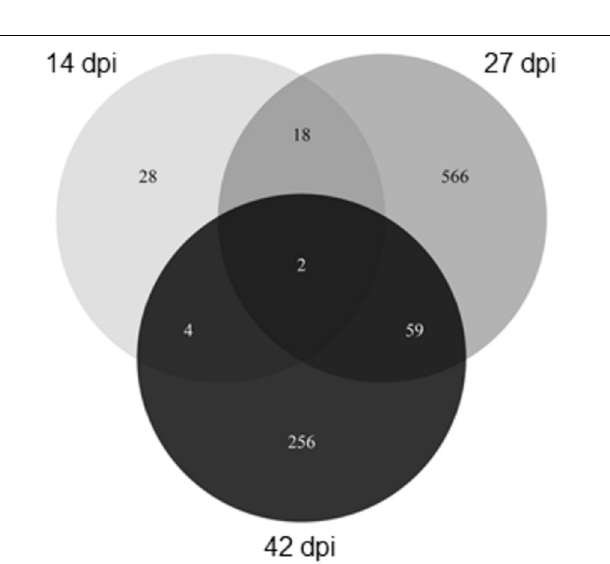
FIGURE 4 | Number of Plasmodiophora brassicae DEGs between N supply conditions. The Venn diagrams show the number of significantly DEGs ( P < 0.05) between N1 and N8 for both genotypes between sampling dates. DEGs, differentially expressed genes; dpi, days post-inoculation; N1, 1 mM nitrogen supply, N8, 8 mM nitrogen supply.